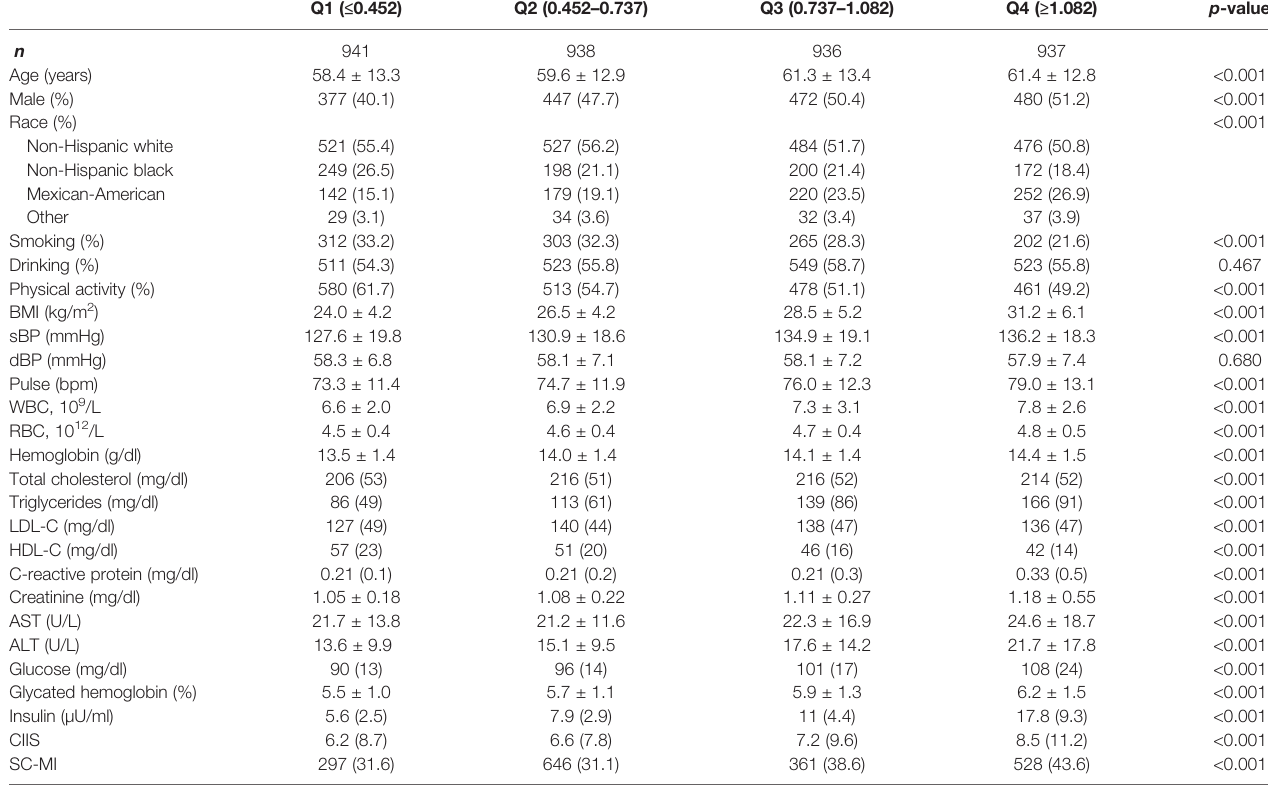
TABLE 1 | Baseline characteristics of study participants across serum C-peptide